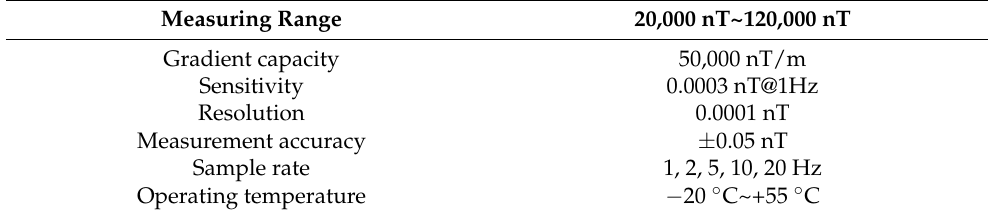
Figure 11. Aeromagnetic interference model: ( a ) Flight C; ( b ) Flight D.